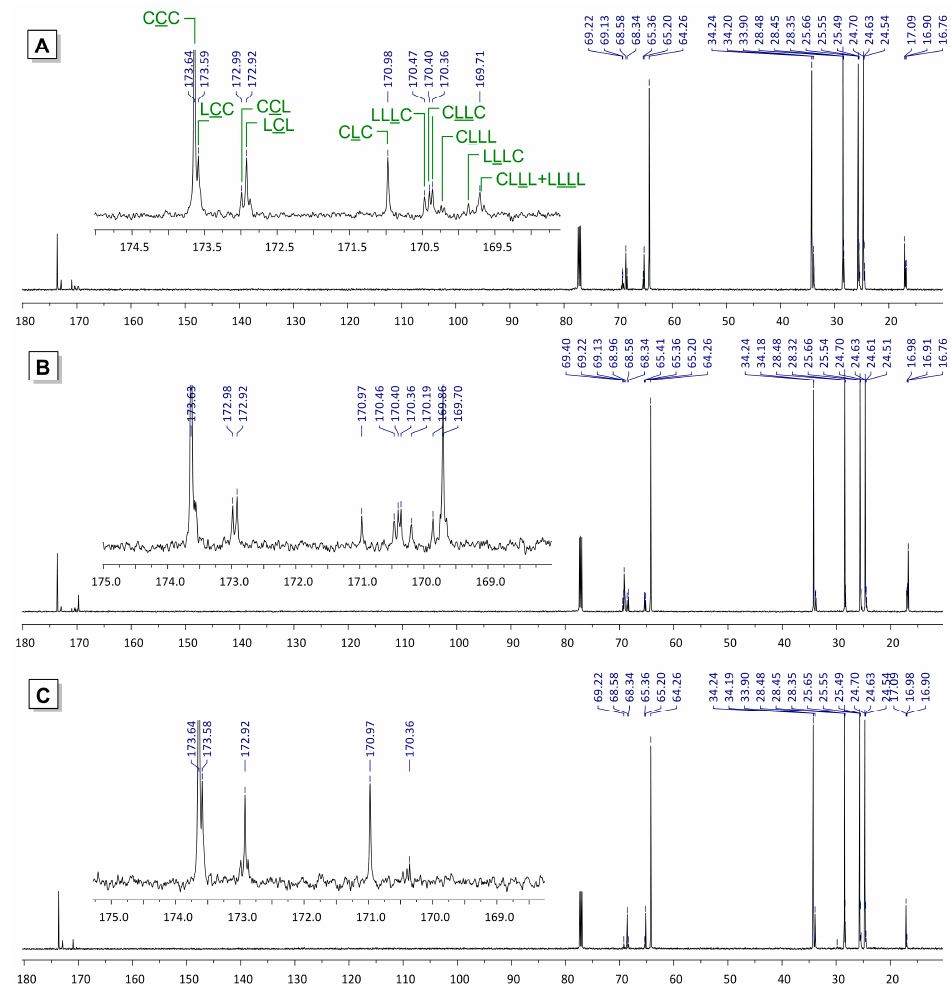
Figure 4. 13 C NMR spectra (CDCl 3 , 20 ◦ C, 151 MHz) of the products of l LA / ε CL copolymerization using 3 ( A ) and 4 ( B ) as a catalysts, and transesterification of PLLA by ε CL in the presence of 3 ( C ).